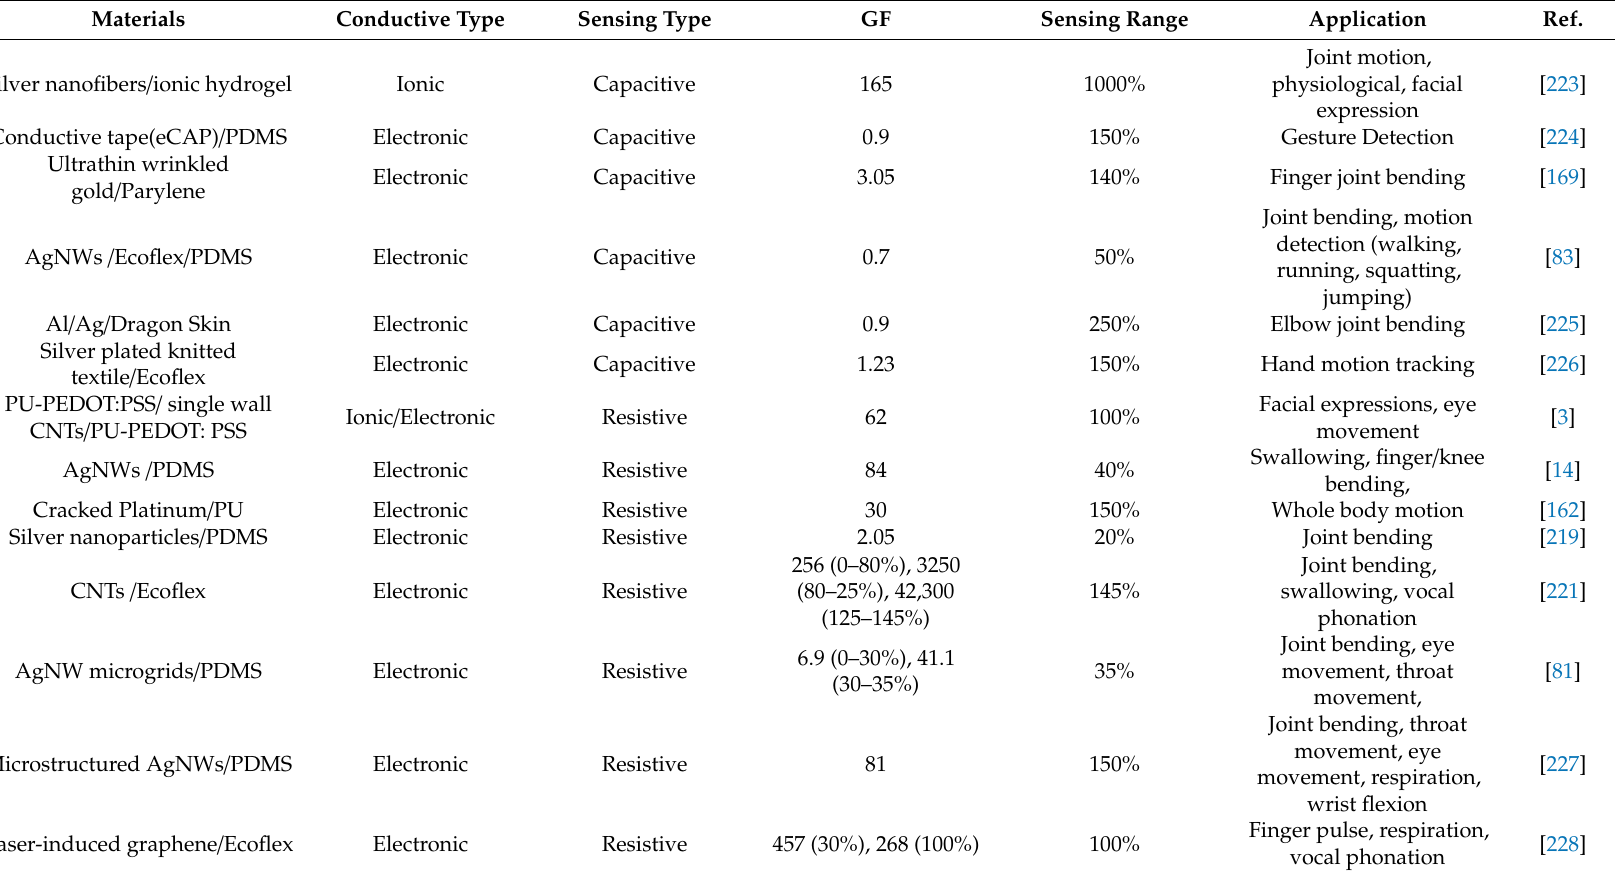
Table 2. Summary of performances of representative wearable strain sensors for motion detection